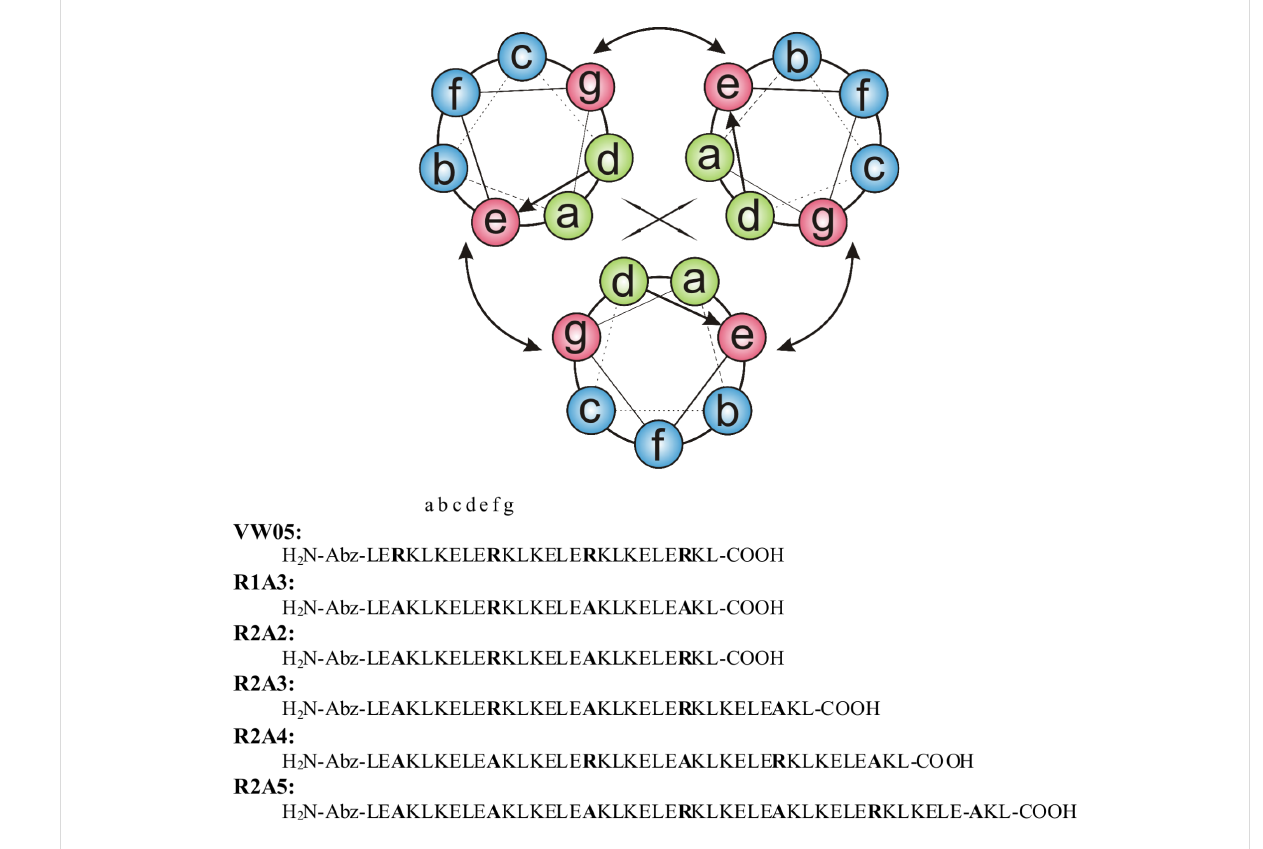
Figure 1: Helical wheel representation and sequences of the peptides used in this